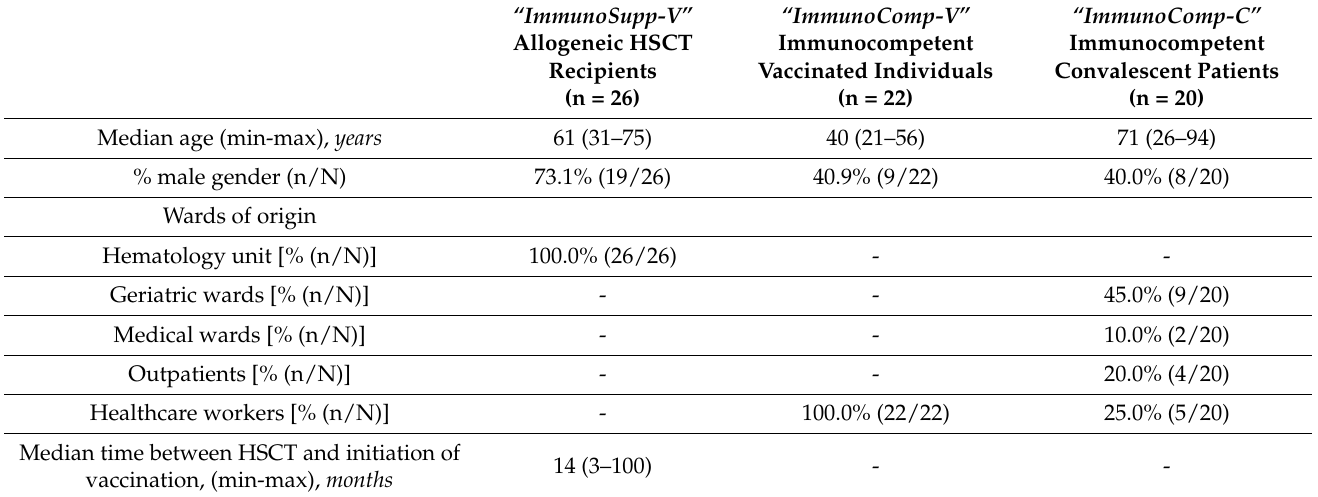
Table 1. Characteristics of the study population, including 3 cohorts: (i) 26